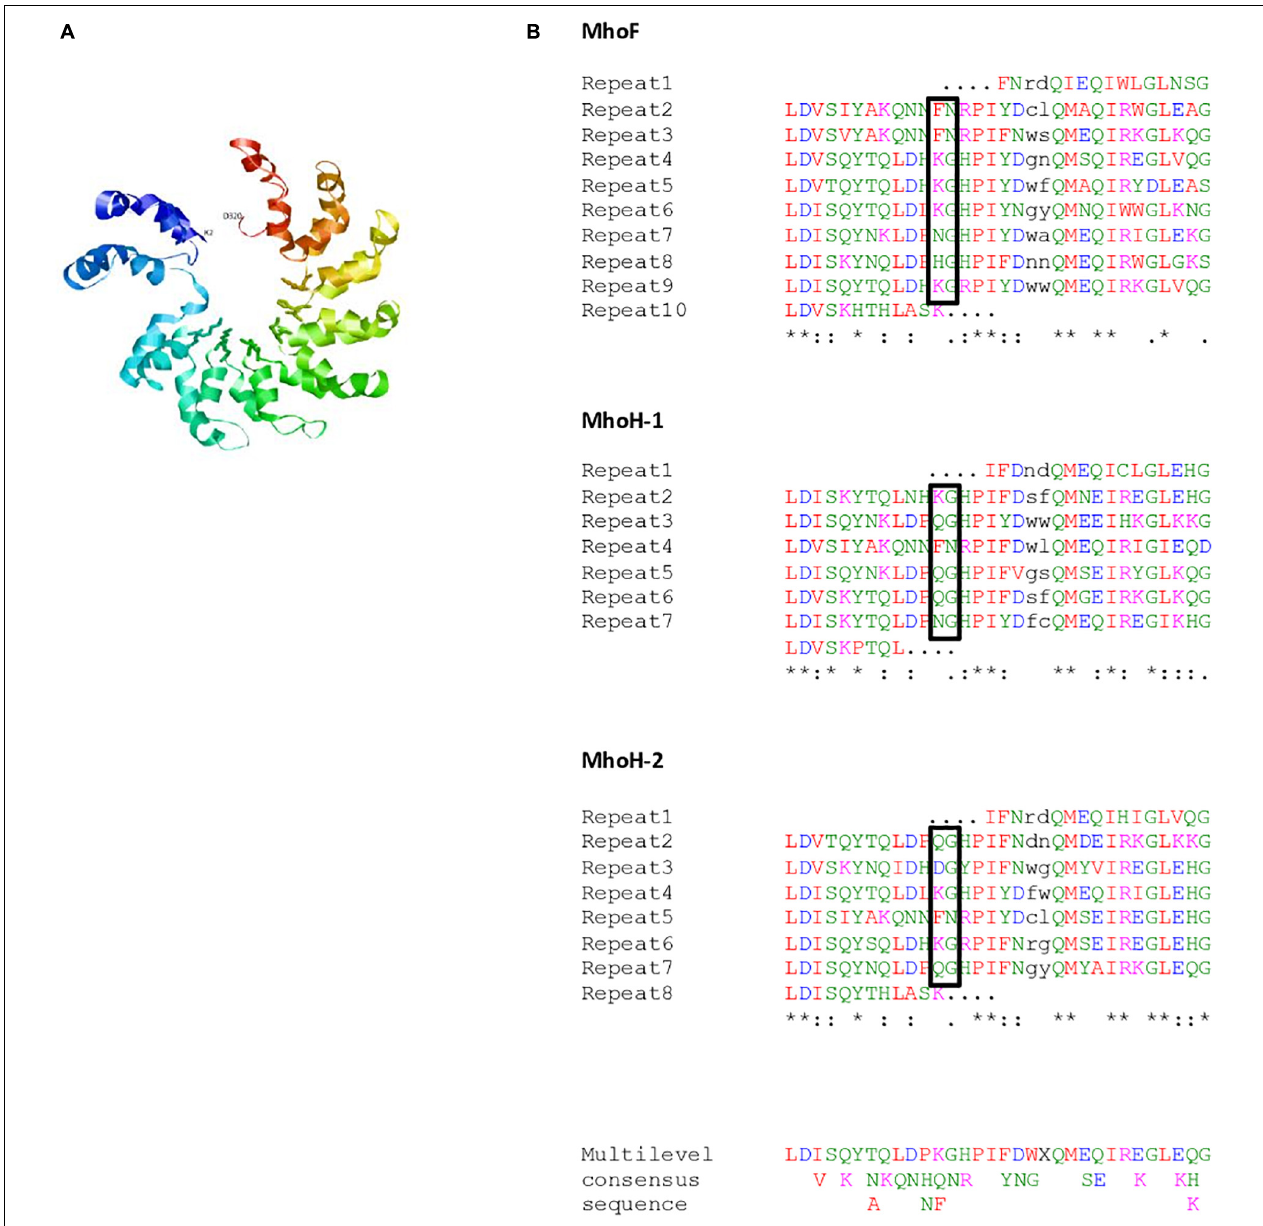
FIGURE 3 | (A) Predicted structure for MhoF (residues 2–320) modeled using Phyre2. Variable residues (putative repeat variable di-residue [RVD]) at positions 12 and 13 of the double helix are shown using balls and sticks representation. (B) Repeated sequences in MhoF and MhoH sequences. The repeated sequences identified using the RADAR algorithm were further refined using Phyre2 alignments. Repeats were aligned using Clustal Omega. Amino acids (aa) with similar physicochemical properties are shown in the same color: red, small and hydrophobic aa; blue, acidic aa; magenta, basic aa; green, hydroxyl, sulfhydryl, and amine aa. The two residues of the double helix that are not repeated are indicated in black. Most variable di-residues within MhoF repeats, and corresponding di-residues in MhoH, are shown in boxes. ∗ Conserved residues among repeats for each protein without taking into account the truncated repeats. The multilevel consensus sequence was identified using MEME